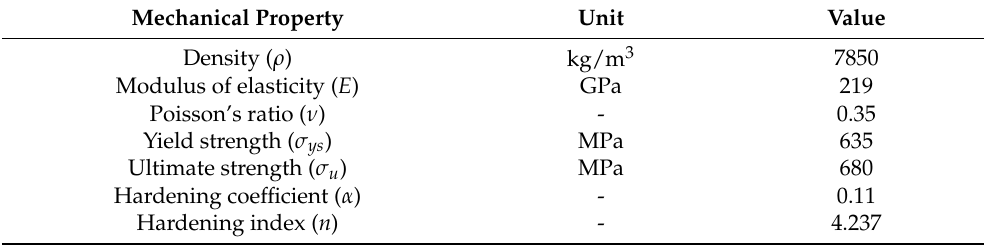
Table 1. Material mechanical properties of Ni-Cr-Mo-V high-strength steel at room temperature.